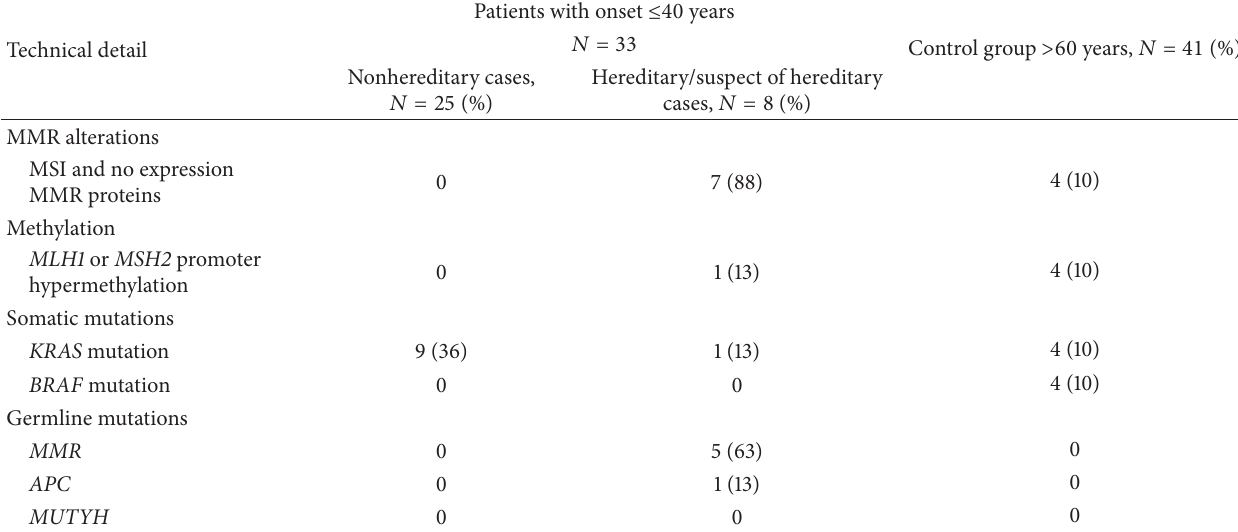
Table 2: Molecular features of colorectal carcinomas in cases and in the control group.